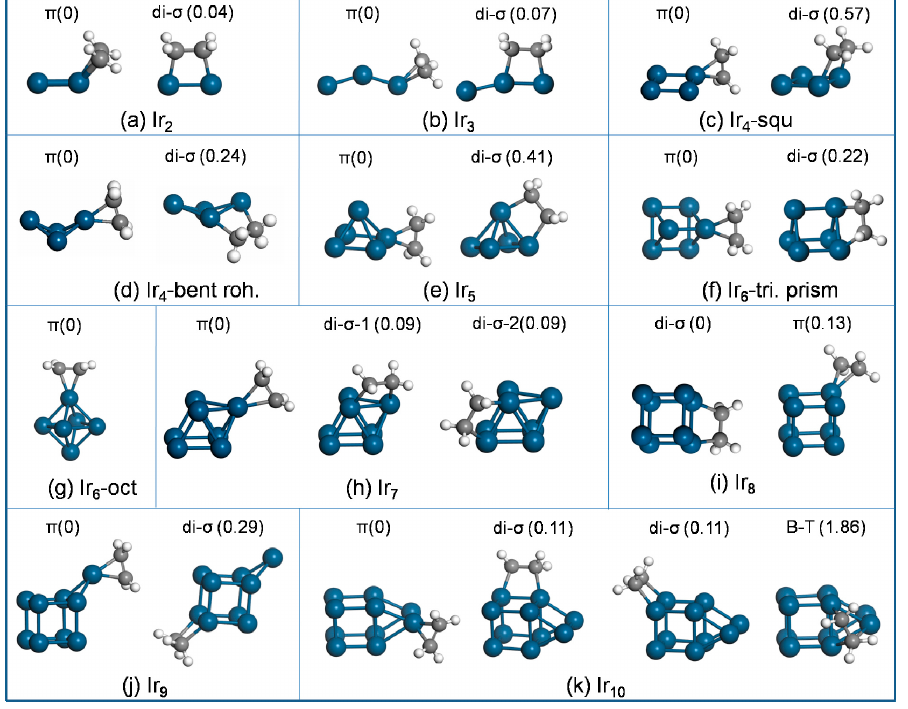
Figure 3. The most stable structure for each ethylene-binding mode on bare Ir n . The energy difference (eV) with respect to the most stable configuration (energy set to 0) is labeled at the top of the figure.